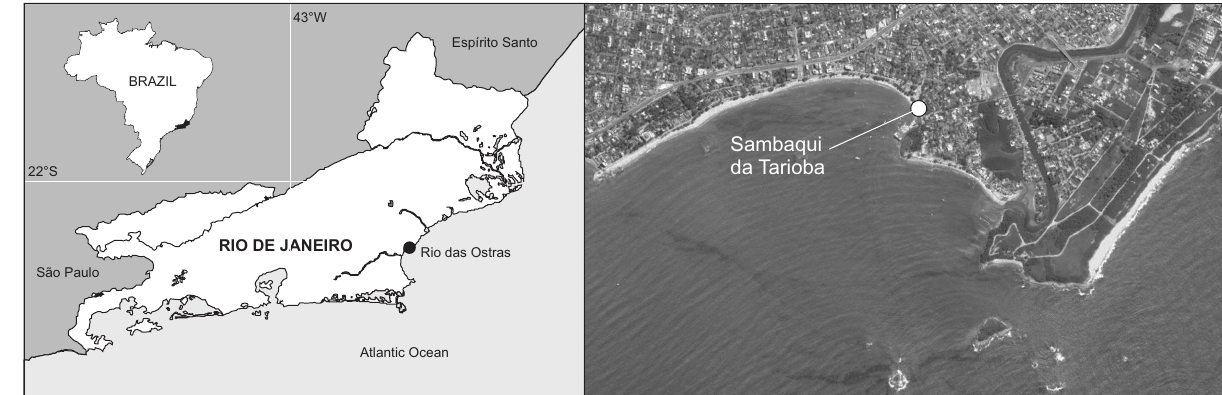
Figure 1. Location of Sambaqui da Tarioba, Rio de